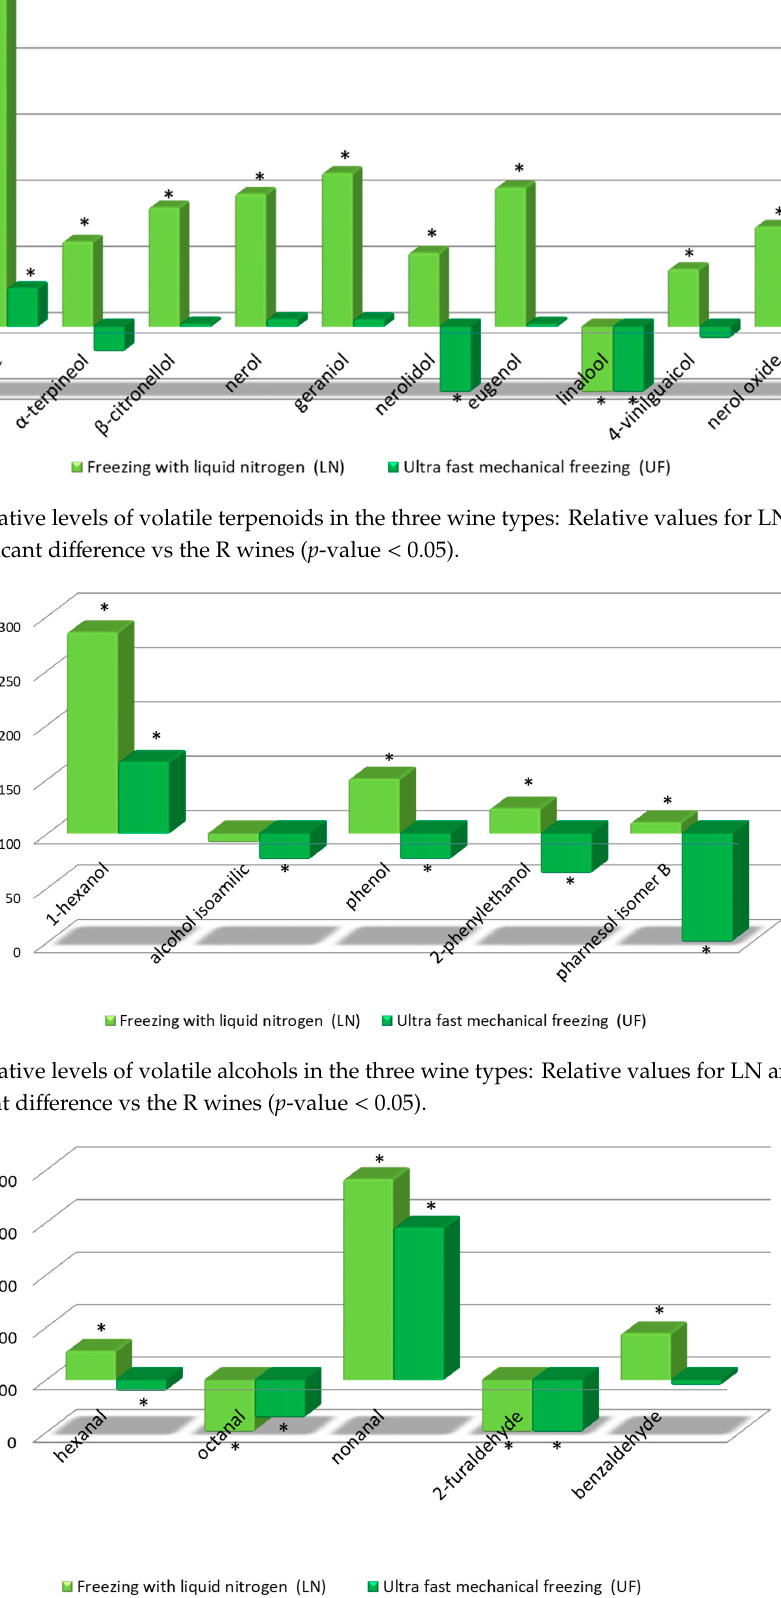
Figure 5. Relative levels of volatile aldehydes in the three wine types: Relative values for LN and UF vs R. * Significant difference vs the R wines ( p -value <